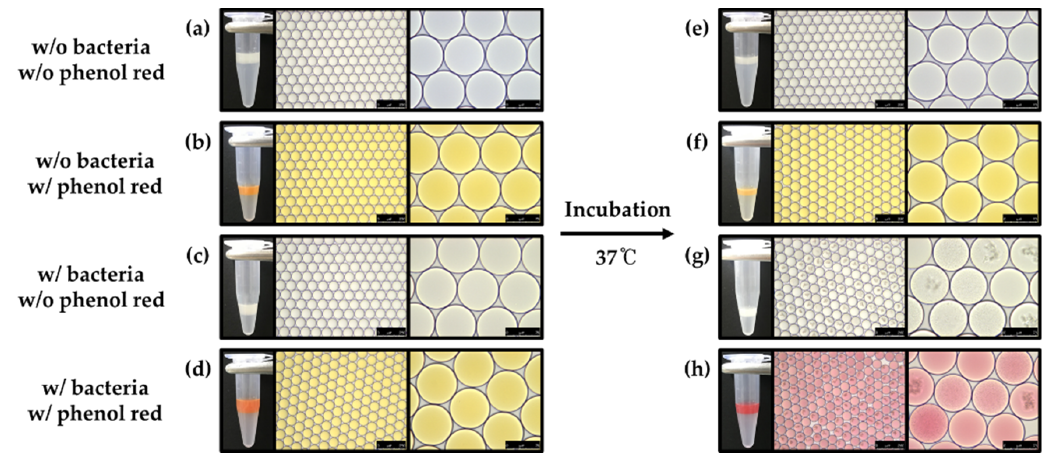
Figure 7. Identification of bacterial growth in droplets using pH indicator. ( a , e ) Empty droplet, ( b , f ) phenol red droplets, ( c , g ) bacteria droplet, ( d , h ) co-encapsulated droplets of both phenol red and bacteria (scale bar of left panels = 250 μ m, scale bar of right panels = 75 μ m).